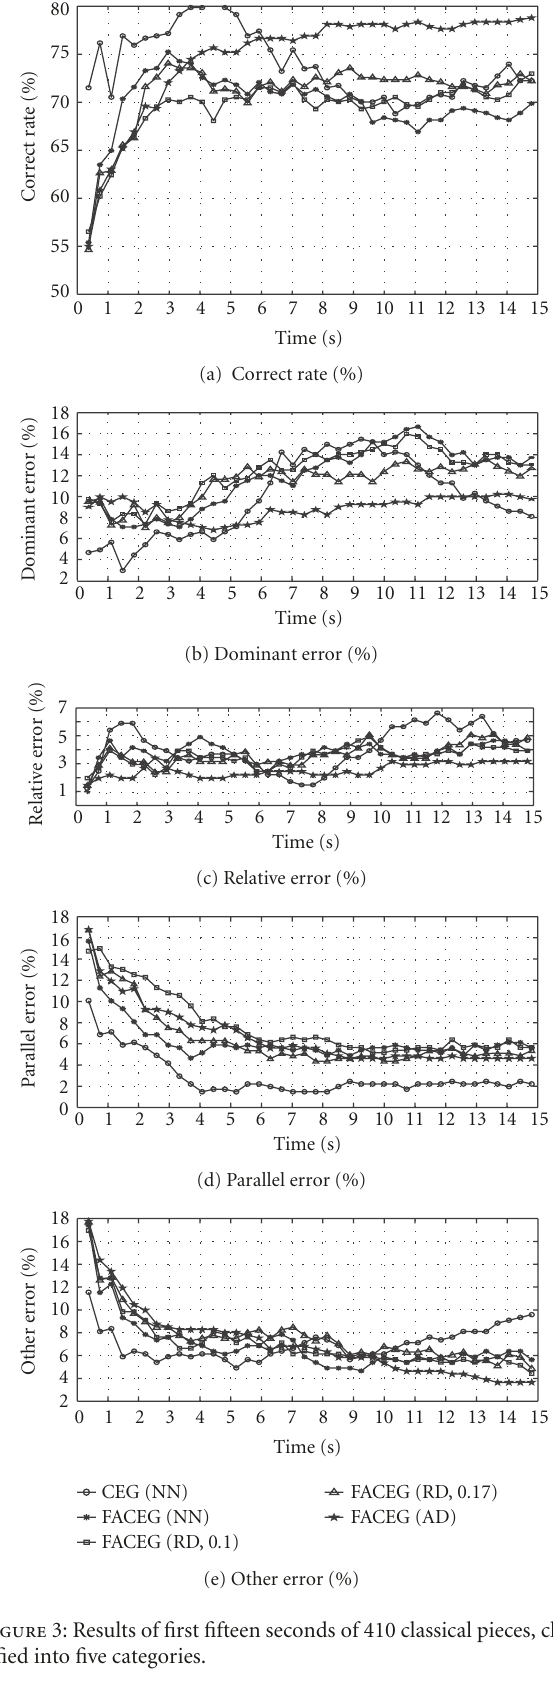
Figure 3: Results of first fifteen seconds of 410 classical pieces, clas- sified into five